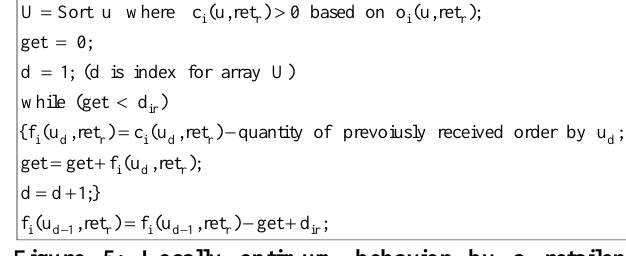
Figure 5: Locally optimum behavior by a retailer ordering product i